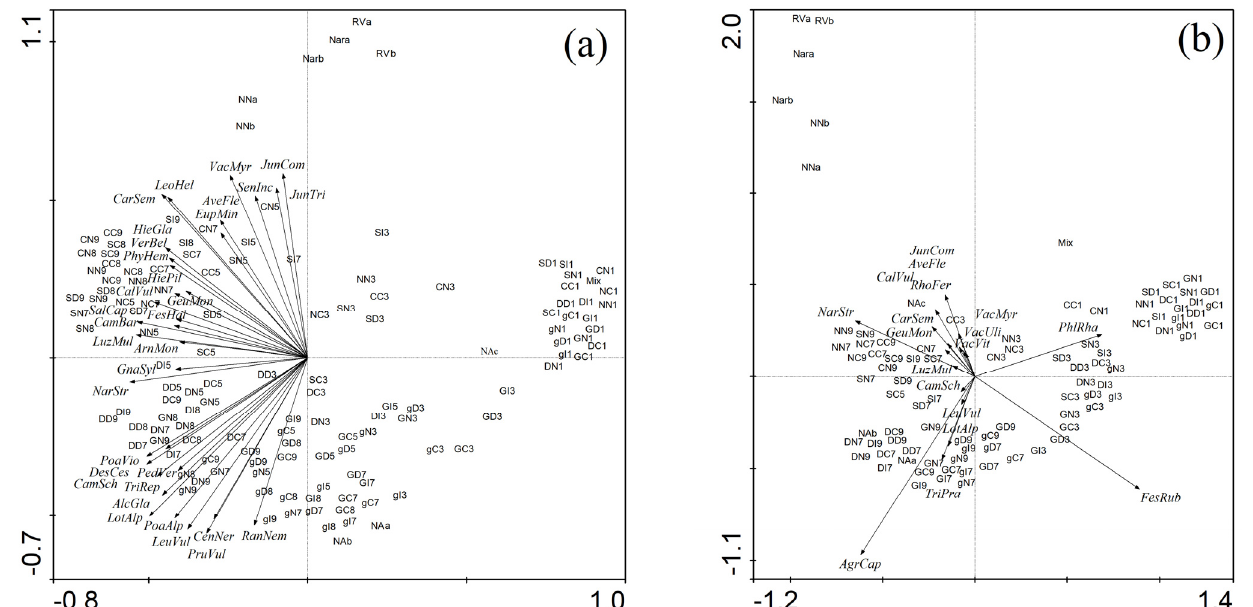
Figure 4. PCA sample-species biplots showing ( a ) the species composition (presence-absence data) and ( b ) vegetation structure (% cover data) of 128 treatments from a ski slope grassland restoration experiment. Codes of the experimental treatments are as follows: first character, G, g, S, D, N, and C, type of propagation material (see legend of Table 2); second character, C, I, D, and N, continuous, initial, delayed and no fertilisation, respectively; third character, 1, 3, 5, 7, 8, and 9, year after sowing. Further, samples of the donor grassland and receptor site vegetation are shown with codes as follows: NAa-NAc, Nardo-Agrostion donor grassland; Nara and Narb, Nardion strictae receptor site grassland; RVa and RVb, Rhododendro ferruginei—Vaccinion myrtilli vegetation; NNa and NNb, non-sown ski slope vegetation. Species codes are composed of the first three letters of genus name and species epithet (see Table S3). Species variances are explained by principal components 1 and 2: 21% and 10% in ( a ), and 31% and 20% in ( b ). Scaling of ordination scores focused on inter-sample distances. Species shown were selected according to the species fit criterion. For simplicity, in graph ( b ) only samples of years 1, 3, 7, and 9 after sowing are shown (samples from years 5 and 8 are intermediate between the previous and follow- ing year).